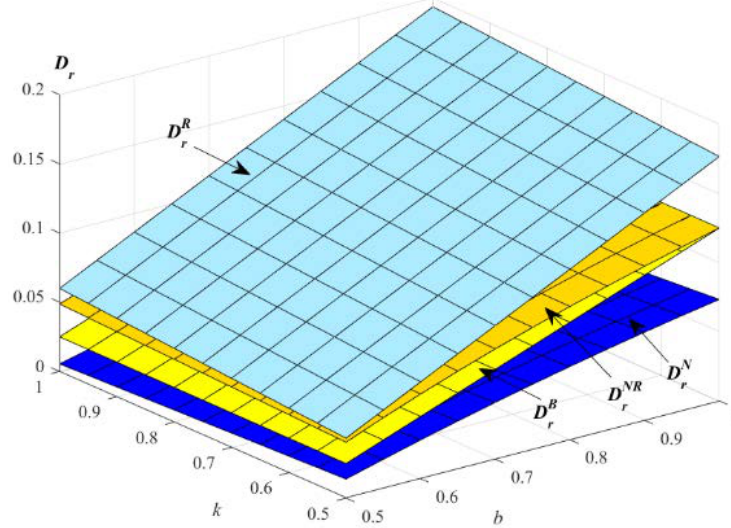
Figure 3. Impact of k and b on the optimal demand for remanufactured products.